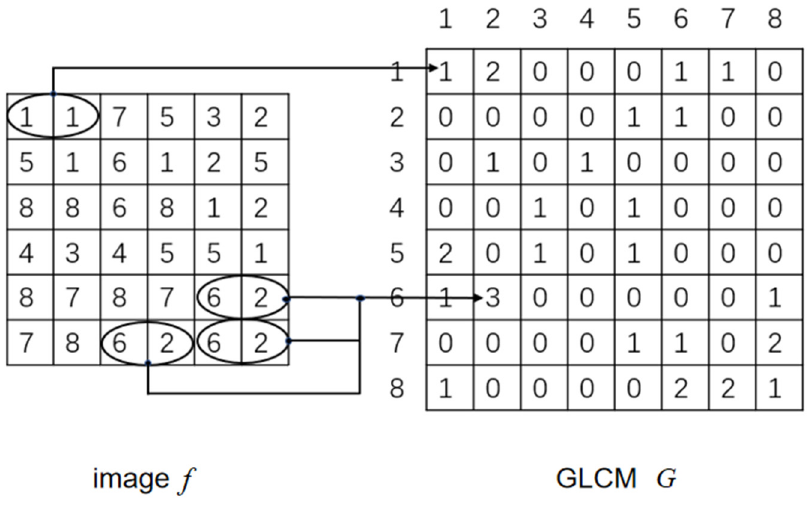
Figure 16. How to generate the gray-level co-occurrence matrix (GLCM).